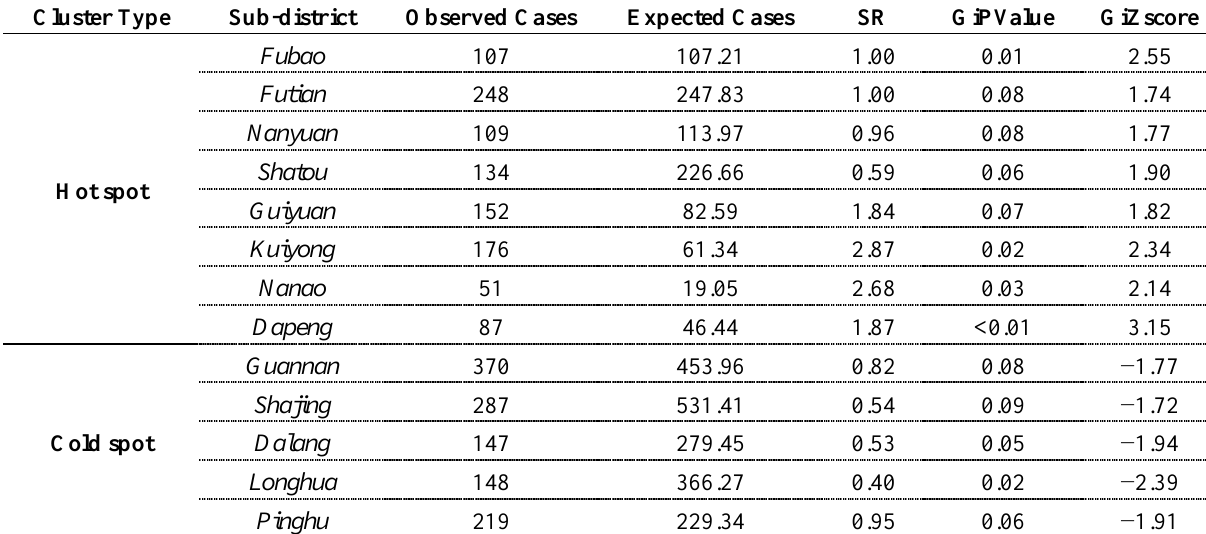
Table 1. The results of hot spot analysis based on the Gi*